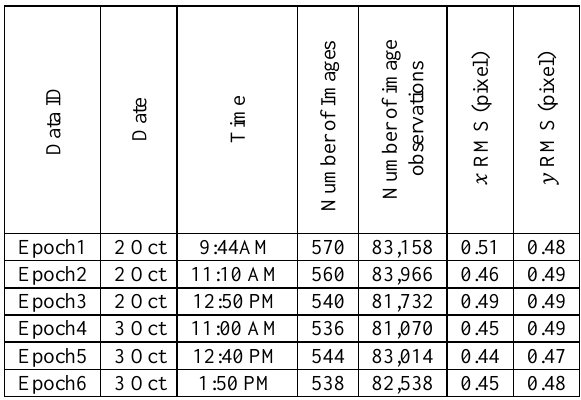
Figure 3. Dual Fluoroscopy imaging system components; (a) time synchronized X-ray sources (G-1086, Varian, USA), (b) instrumented treadmill (Bertec, USA), (c) 406 mm diameter quad-mode image intensifiers (E5876SD-P2A, Toshiba, Japan), and (d) high-speed video cameras (DIMAX, PCO, Germany) Table 1. Six epochs of calibration data